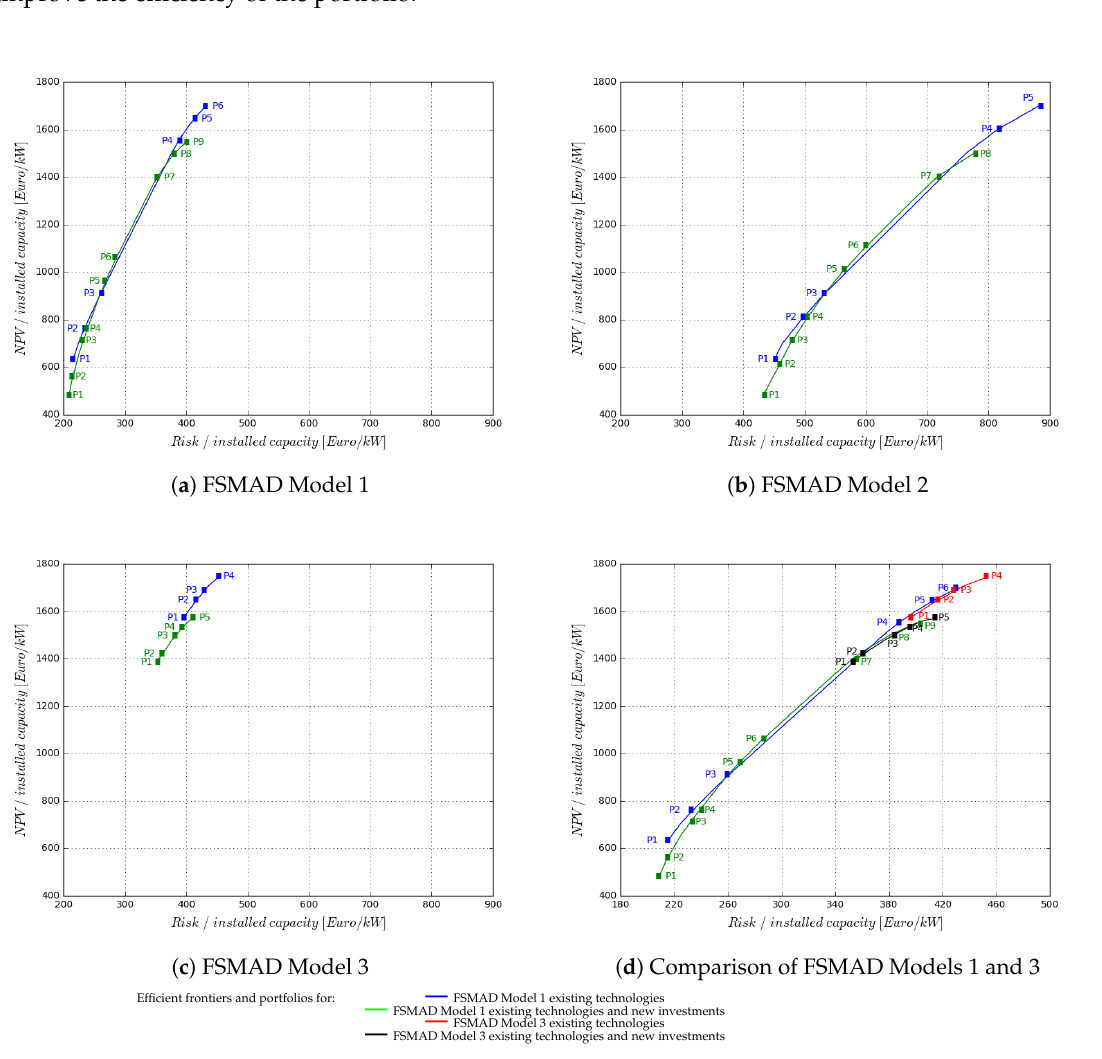
Figure 1. Efficient frontiers obtained for different FSMAD